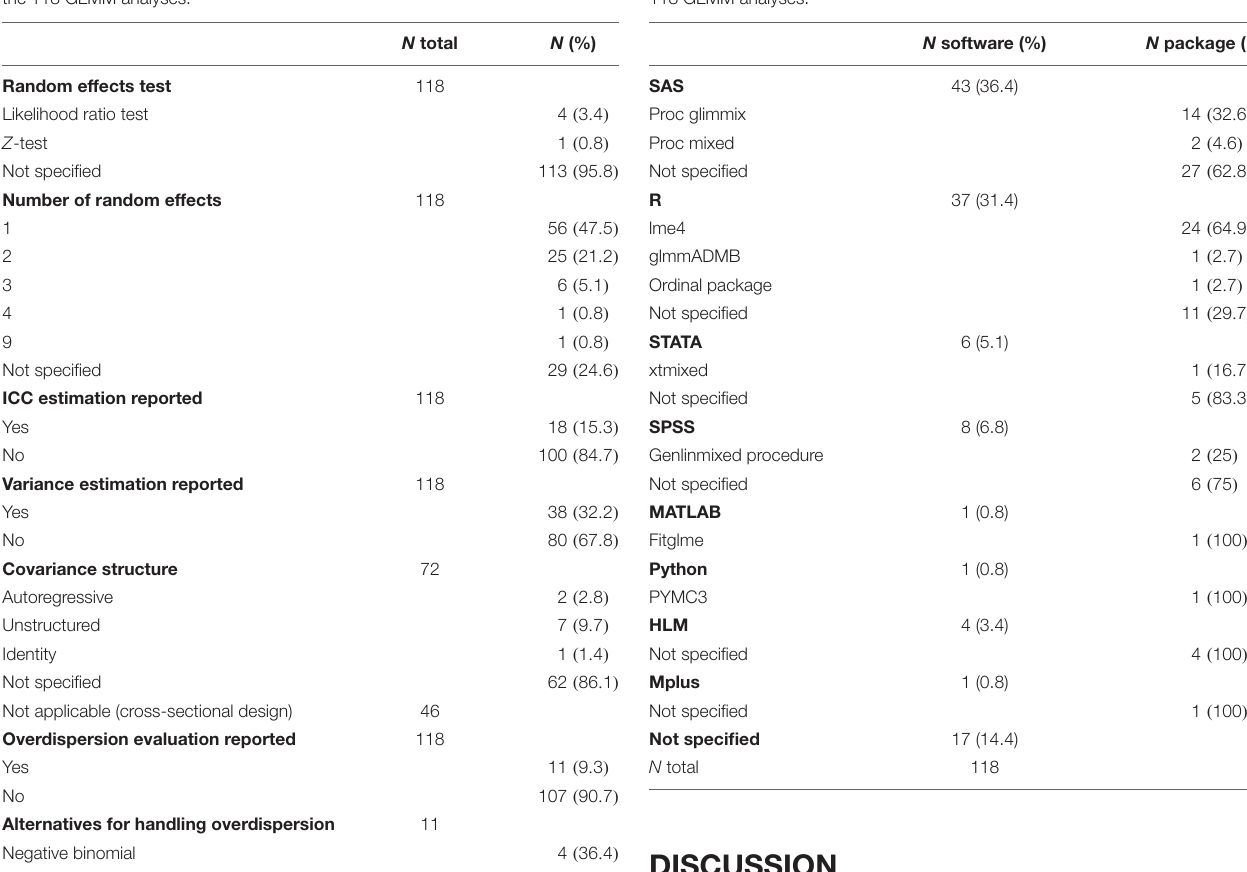
TABLE 5 | Statistical inference of random effects and overdispersion evaluation in the 118 GLMM analyses.